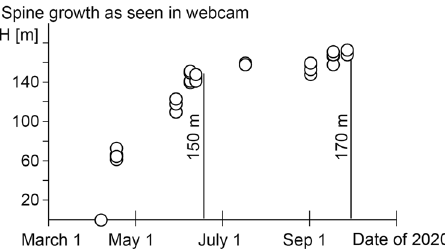
Fig. 2 Spine growth tracking derived from webcam data at 43 km distance. Tracking results suggest a spine height growing quickly between March and June 2020, reaching 150 m in June (i.e., the fi rst three months), and then only slowly increasing to 170 m over the following three